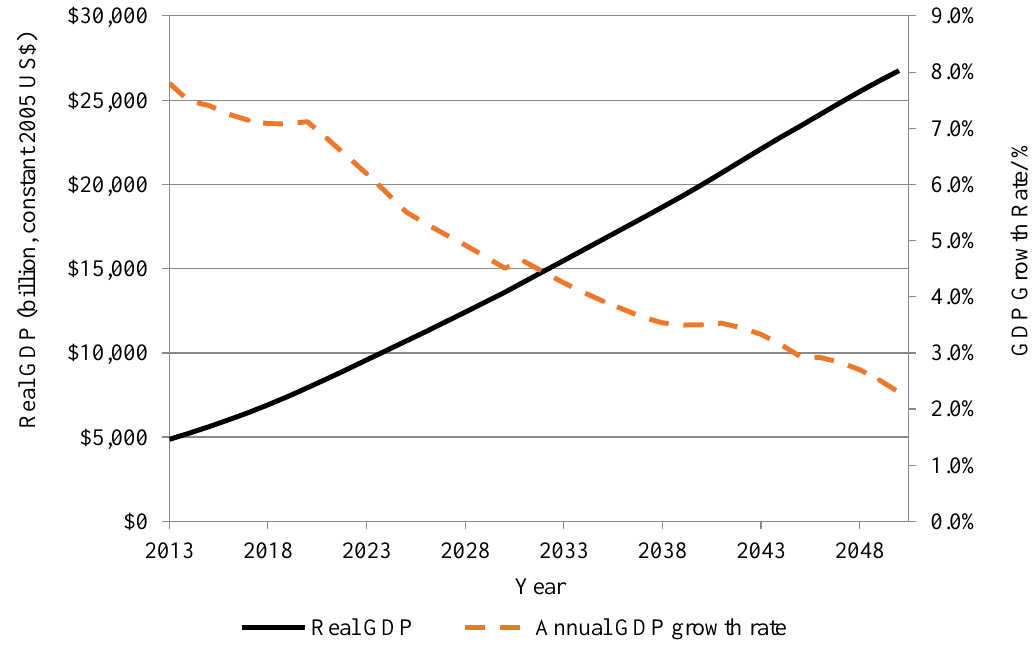
Figure 5. Economic growth trends in China